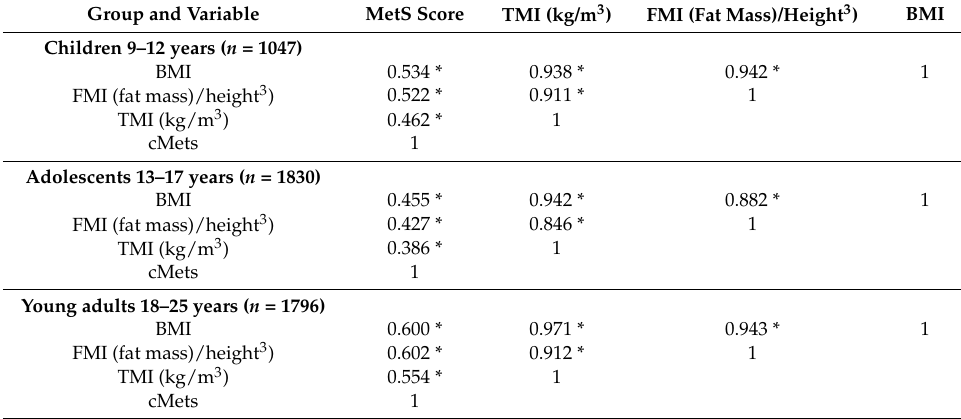
Table 2. Results of the partial correlation analysis between body mass index (BMI), fat mass index (FMI), Tri-ponderal Mass (TMI) and a continuous score of the five MetS. Group and Variable MetS Score TMI (kg/m 3 ) FMI (Fat Mass)/Height 3 ) BMI Children 9–12 years ( n = 1047) BMI